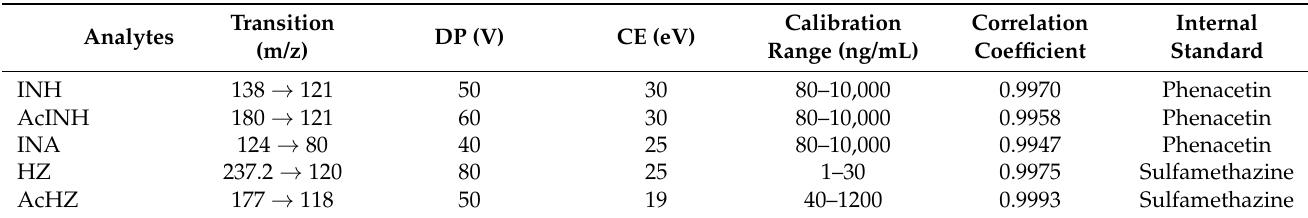
Table 1. Multiple reaction monitoring parameters, calibration range, correlation coefficient, and IS for all five